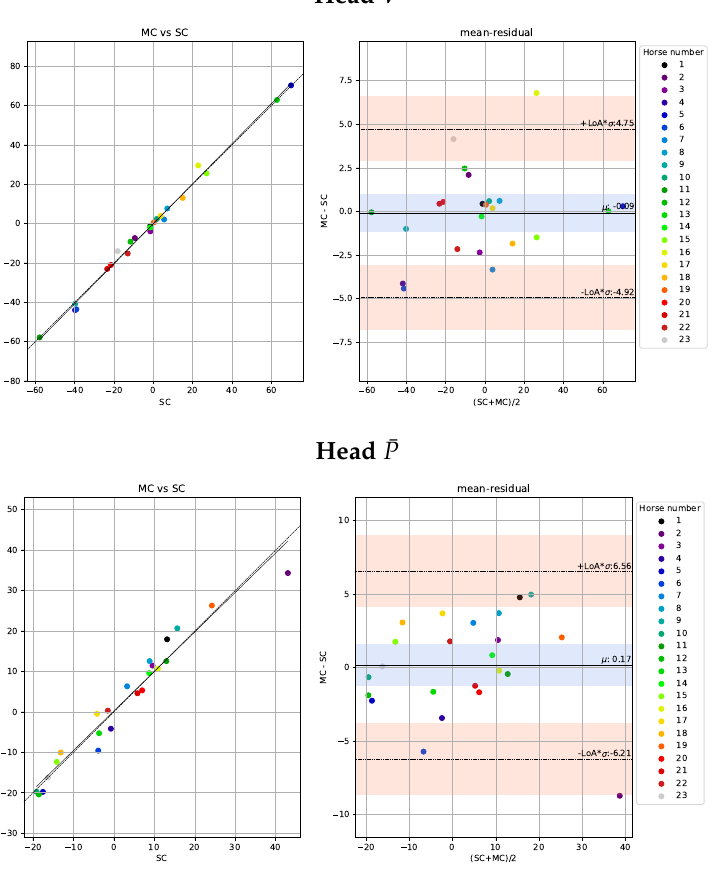
Figure 9. Trial-level scatter plots of the head metrics from the 23 included horses measured by the marker-based motion capture system (MC) versus the single-camera markerless system (SC) are presented in the left panel. Agreements between the systems, with limits of agreement (LoA) displayed as orange horizontal lines, are presented in the Bland-Altman plots in the right sub-panels. In the top row, we show ∆ ¯ V (trial mean MinDiff) and in the bottom row, we show ∆ ¯ P (trial mean MaxDiff) defined in Section